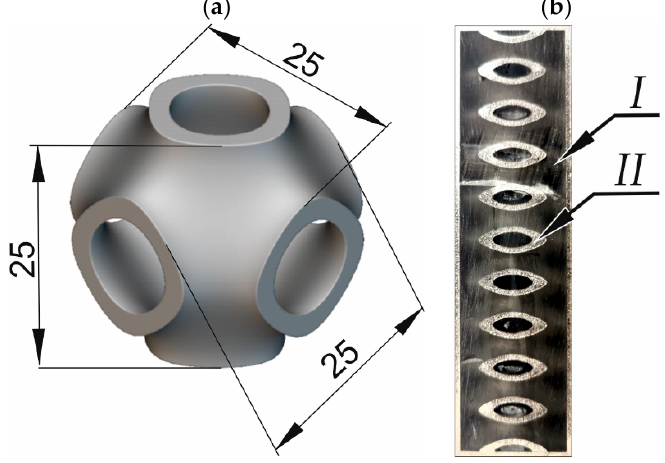
Figure 1. Sample view of: ( a ) an individual Schwarz-P cell, ( b ) a real 3D metal composite: I—polymer, II—3D-printed stainless steel 316L.